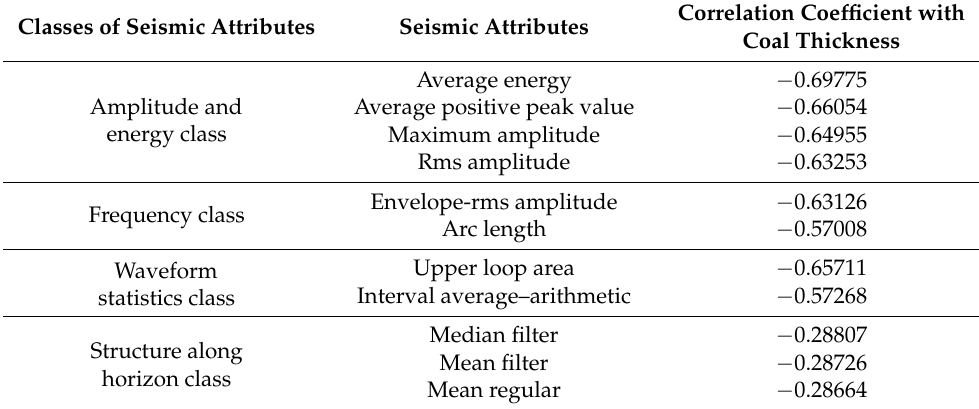
Table 1. Seismic attribute correlation analysis in the exploration